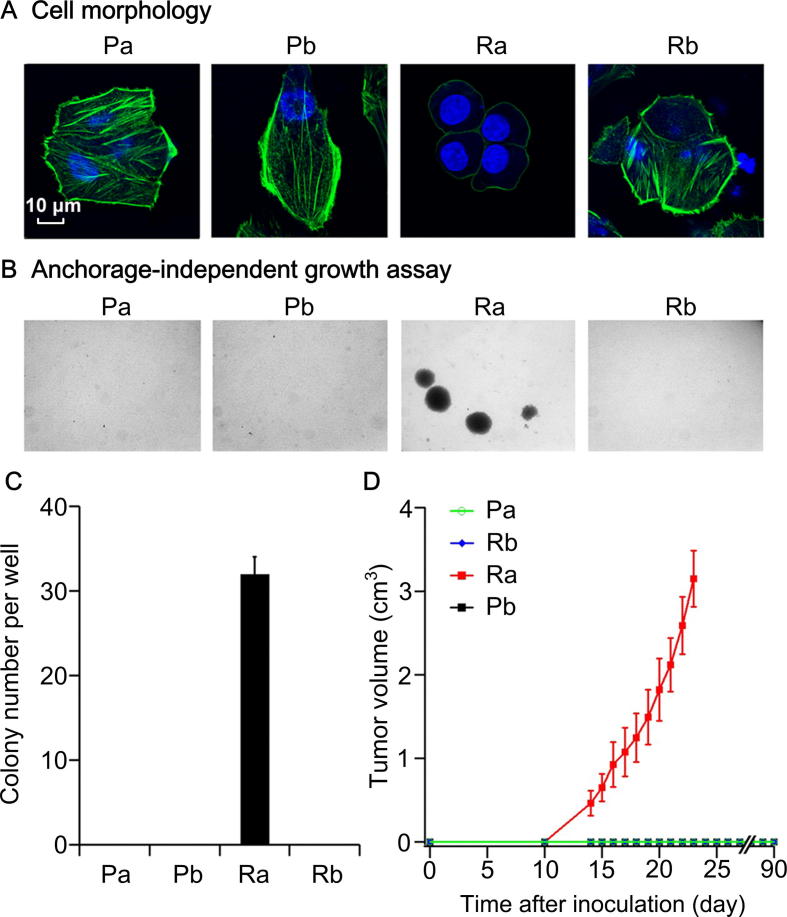
Specific cell morphology and tumorigenicity of Ra compared with Pa, Pb, and RbA. Morphology of Pa, Pb, Ra, and Rb. Green indicates phalloidin-stained F-actin, and blue indicates the cell nucleus stained with DAPI. Bar = 10 μm. B. Soft agar assays (40 ×). Colonies were microscopically visualized. C. Quantification of colonies formed in each well. 3 wells per group (repeated twice). Data are shown as mean ± SEM. D. Growth curves of tumors after subcutaneous injection of Pa, Pb, Ra, and Rb cells into the armpits of each NOD/SCID male or female mouse (4–6 weeks old). Tumor formation was monitored weekly after transplantation. Two weeks later, tumors were detected only in the Ra-transplanted mice. Ra tumor was monitored for the continuous growth and was removed on day 25 due to the large tumor size. No tumors were formed in the mice transplanted with Pa, Pb, or Rb, even after 90 days. Values are presented as mean ± SEM (5 mice in each group).